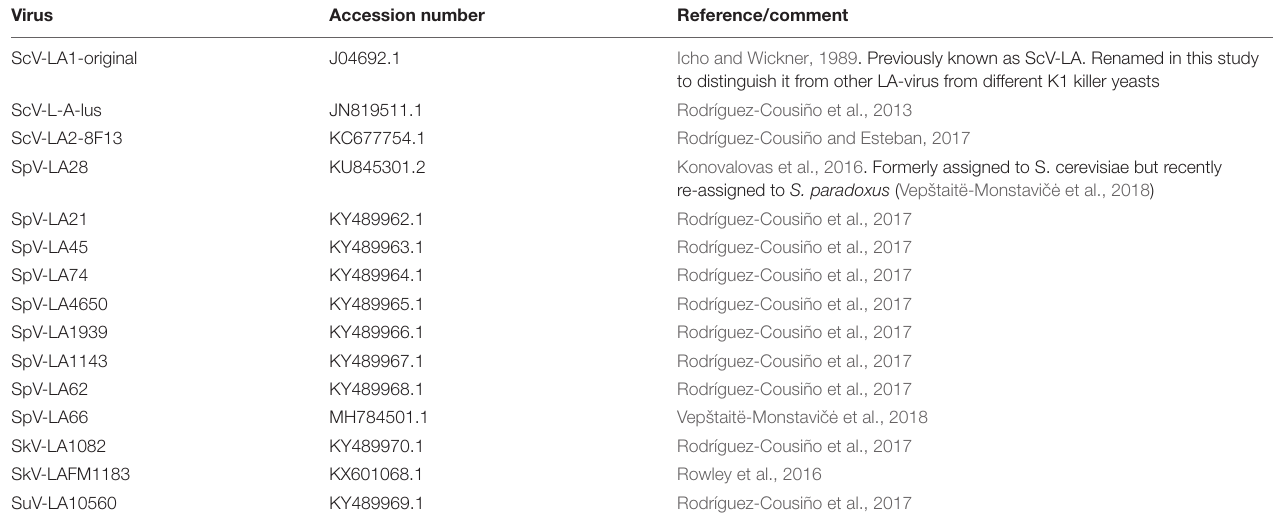
TABLE 2 | Previously known sequence of yeast LA viruses used in this